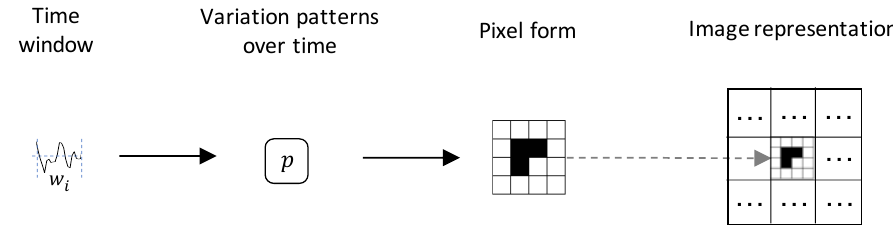
Figure 1. Image generation